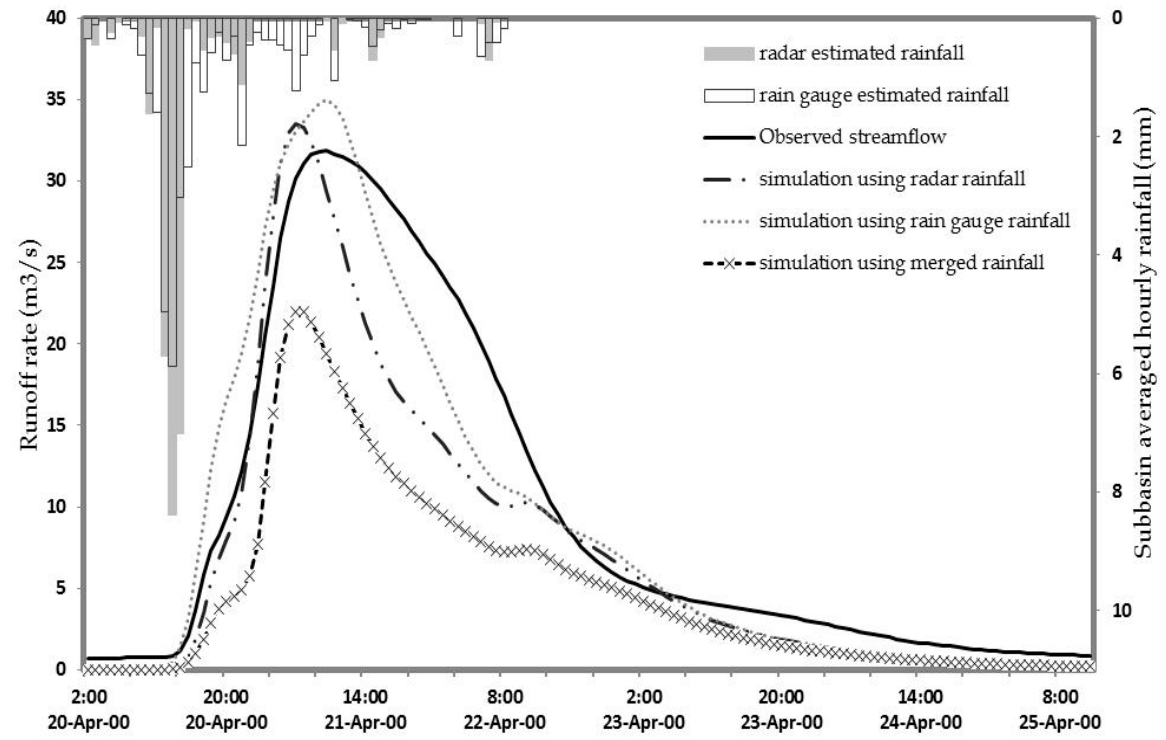
Figure 9. Comparison of estimated and observed hydrographs using different rainfall estimates for the 20 April 2000 event with SCS modeling option.